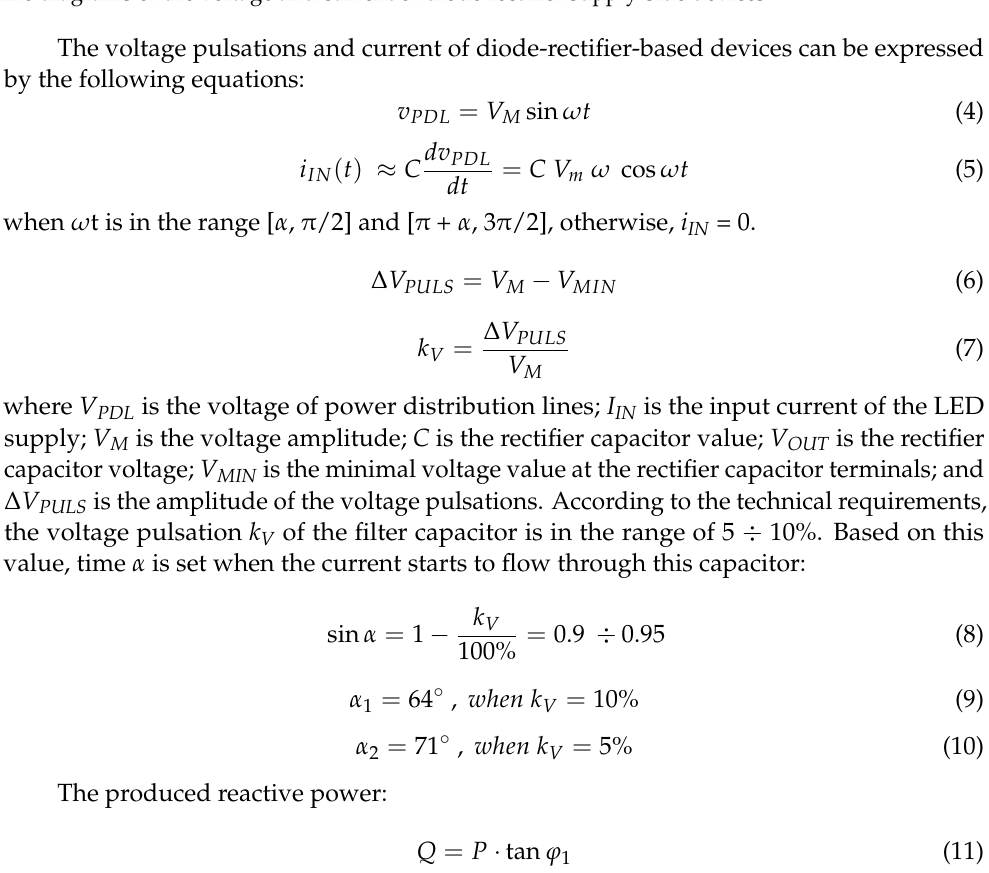
Figure 2. Time diagrams of the voltage and current of diode rectifier supply-side devices.